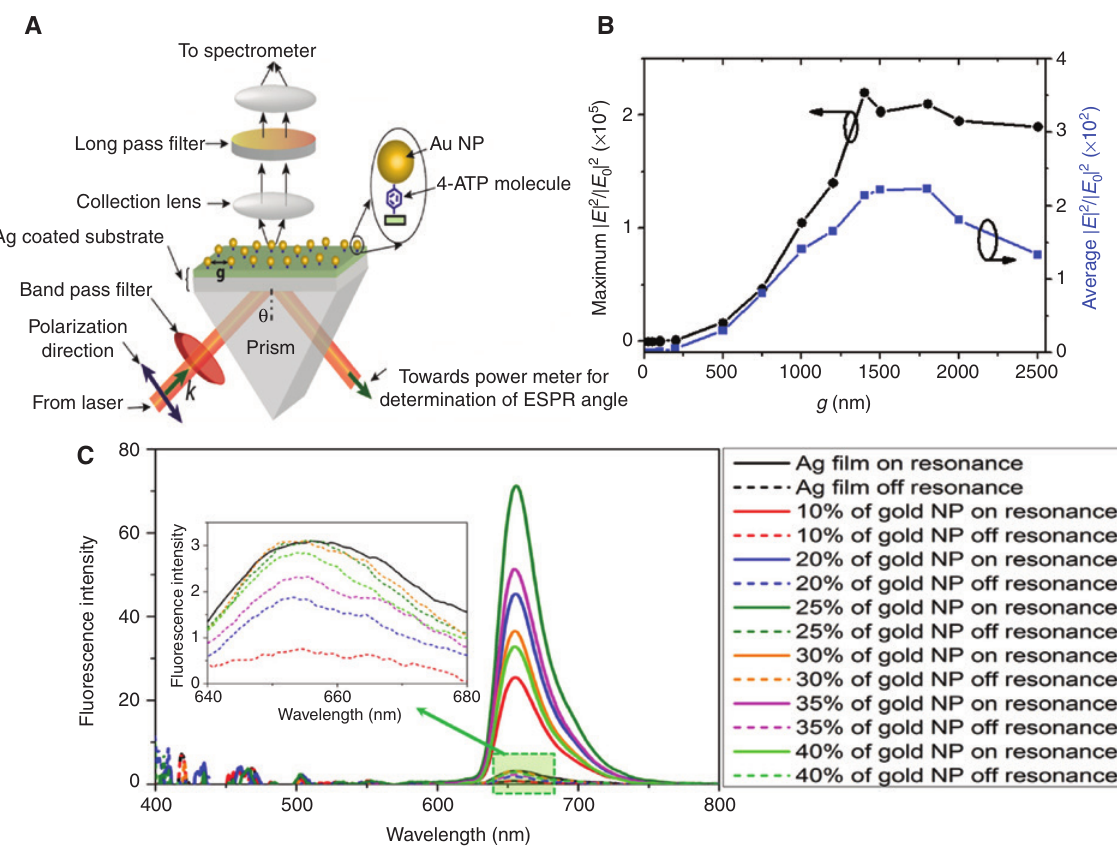
Figure 18: SEF under ultrahigh enhancement with prism configuration. (A) Schematic of the experimental setup used in the ESP-LSP coupling experiments and the measurement of the surface enhanced spectroscopy signals. (B) Effects of the horizontal gap “g” between two Au NPs on the maximum (left) and average (right) electric field enhancement in Au NP arrays over the Ag film at 785 nm with 34.645 ° incidence angle inside the prism. (C) Fluorescence intensity of a monolayer of Rhodamine 6G covered on a 47 nm Ag film with various concentrations of 40 nm Au nanospheres deposited on the Ag film at 532 nm. The low intensity signals between 640 nm and 680 nm are zoomed in and shown in the inset. The incidence angles for the on- and off-resonance conditions are 37.25 ° and 60 ° , respectively. Reproduced with permission from (A–B) [51] and (C) [48].